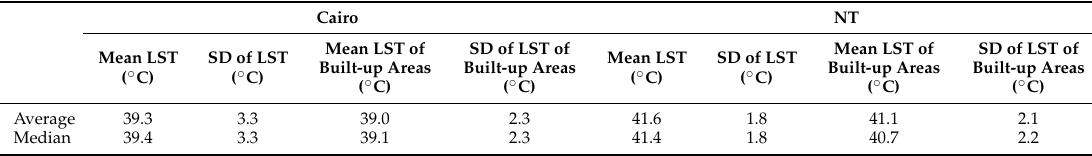
Table 3. Daytime averages and medians of standard deviation and mean of LST in Cairo and NT, and in their built-up areas, during